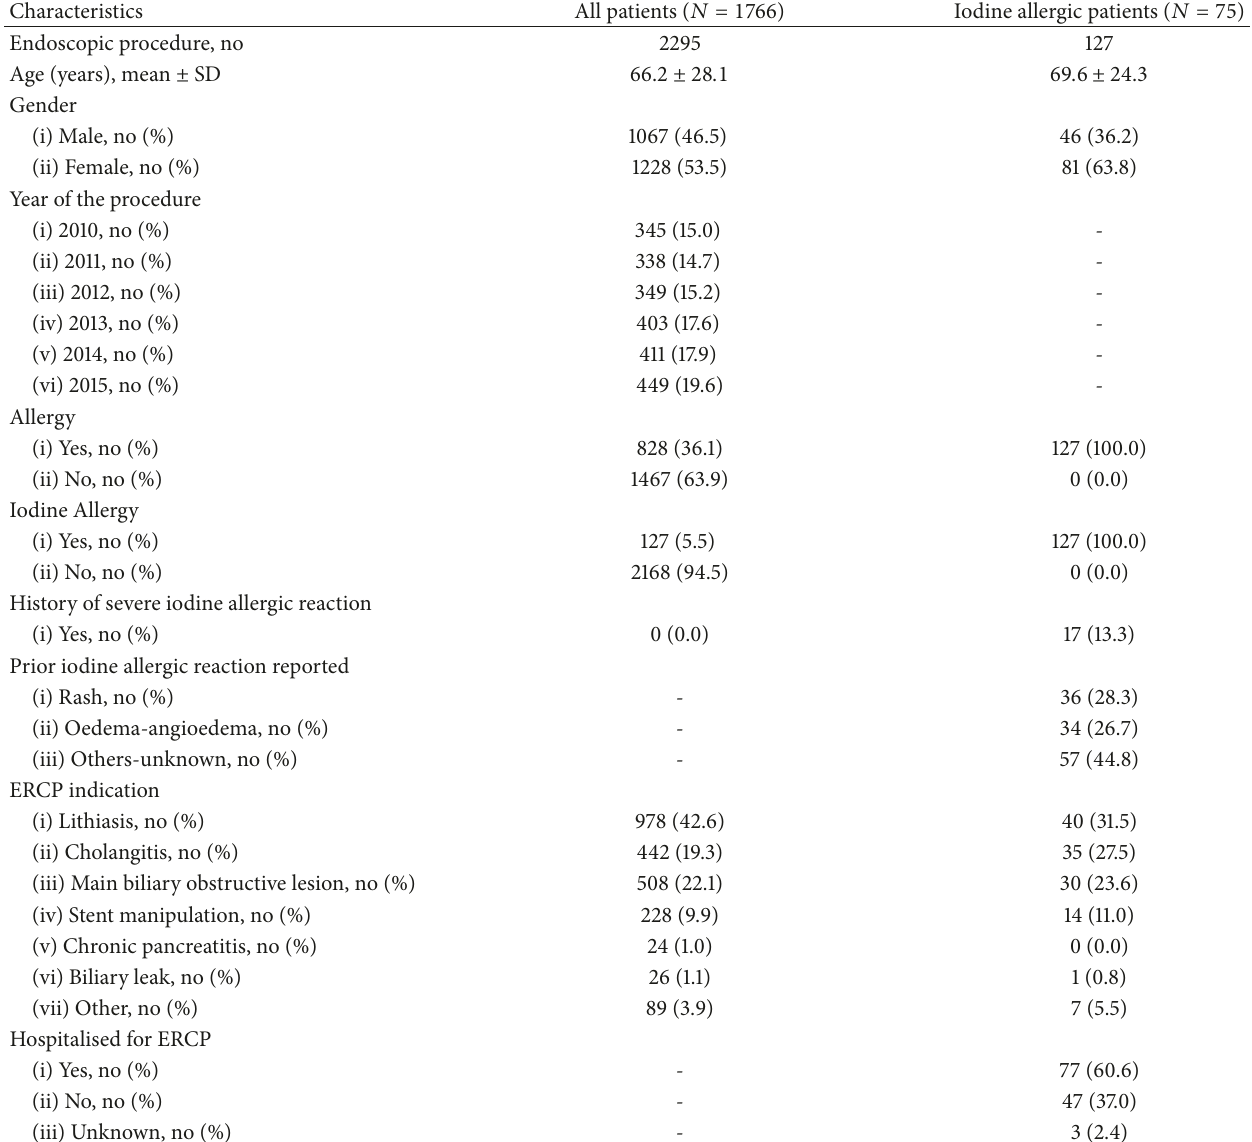
Table 2: Characteristic of study